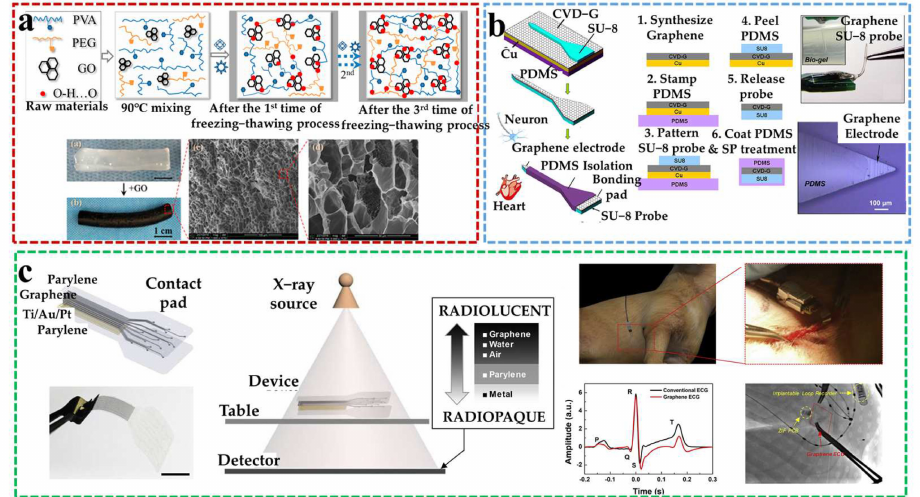
Figure 5. ( a ) Schematic illustrations of the preparation of the PVA/PED/GO sponge ECG elec- trode ( above ) and its digital images ( below ). Reprinted with permission from Ref. [77]. Copy- right 2017, MDPI. ( b ) Fabrication processes and photos of the microprobe graphene ECG electrode. Reprinted with permission from Ref. [81]. Copyright 2013, Elsevier. ( c ) Fabrication processes and photos of the radiolucent graphene ECG electrode and its application in an animal. Reprinted with permission from Ref. [84]. Copyright 2019,